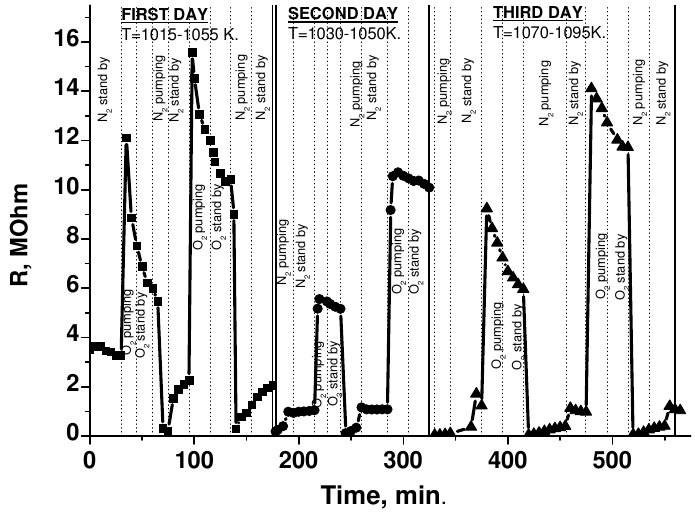
Fig. 2 Dependence of the surface resistance of Pt-YSZ thin films in an atmospheres of differing oxygen content. The sample is obtained by spray pyrolysis. The vertical solid lines separate the thermal treatment done during a particular day. The dotted vertical lines separate each cycle of thermal treatment. The time scale shows the total time of thermal treatment during all days. Shown also is the temperature of heating for each day. The time scale accounts for the total duration of thermal